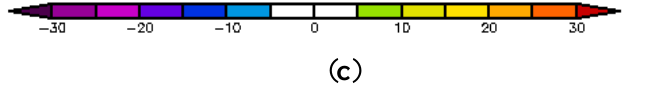
Figure 6. 1000 hPa geopotential height (in m) composites for ( a ) dry and ( b ) wet cases and ( c ) the difference between them following the classification showed in Table